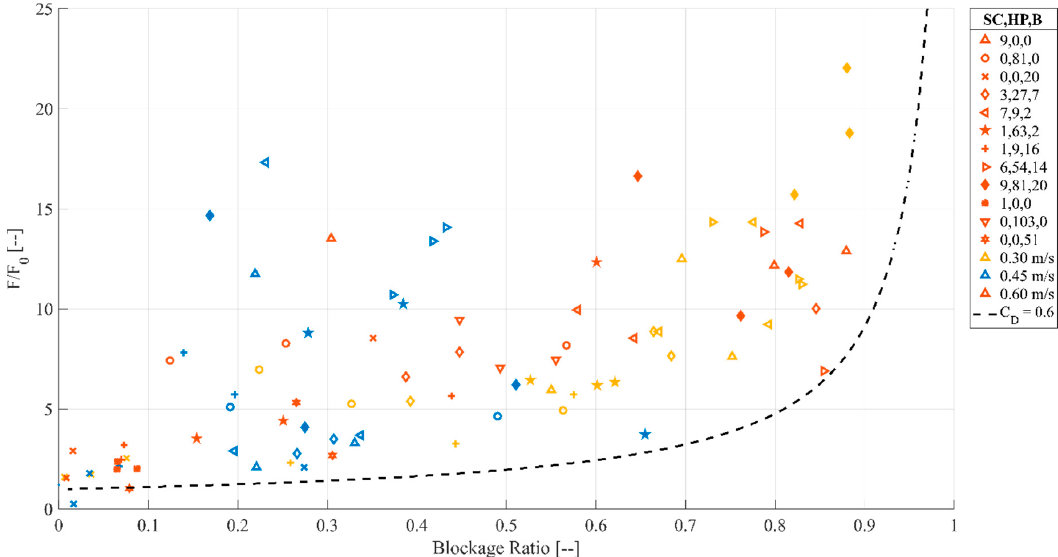
Figure 16. Equilibrium force, normalized by equilibrium force before debris dam forms, as a function of blockage ratio. The debris configuration is denoted by the marker type; the color represents the hydrodynamic boundary condition. The dashed line represents the theoretical increase in force if only the change in blockage ratio is considered.